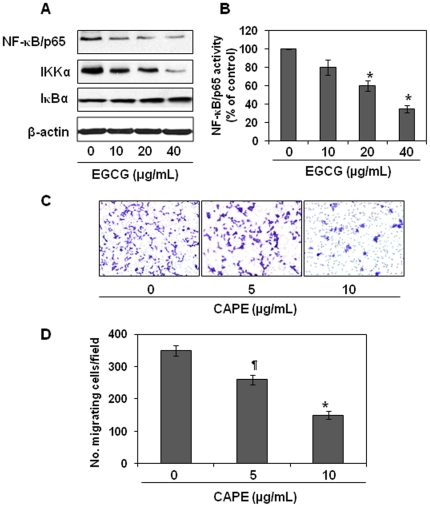
Effect of EGCG on NF-κB activation in melanoma cells.(A) Treatment of A375 cells with EGCG decreases the basal level of NF-κB/p65 and IKKα while inhibiting the degradation of IκBα. After 24 h treatment with various concentrations of EGCG the cells were harvested and cytosolic and nuclear fractions were prepared and subjected to the analysis of NF-κB, IKKα and IκBα using western blot analysis. Representative blot is shown from three independent experiments with identical observations. (B) The activity of NF-κB/p65 in the nuclear fraction of the cells after treatment with and without EGCG for 24 h was measured using NF-κB/p65-specific activity assay kit, n = 3. Activity of NF-κB is expressed in terms of percent of control (non-EGCG-treated) group. Significant decrease versus control: *
P<0.001. (C) Treatment of A375 cells with caffeic acid phenethyl ester (CAPE), an inhibitor of NF-κB, inhibits melanoma cell migration. Representative photomicrographs are shown from three separate experiments. (D) Data on cell migration capacity are summarized as the mean number of migratory cells ± SD/microscopic field, n = 3. Significant inhibition versus non-CAPE-treated cells: ¶
P<0.05; *
P<0.001.